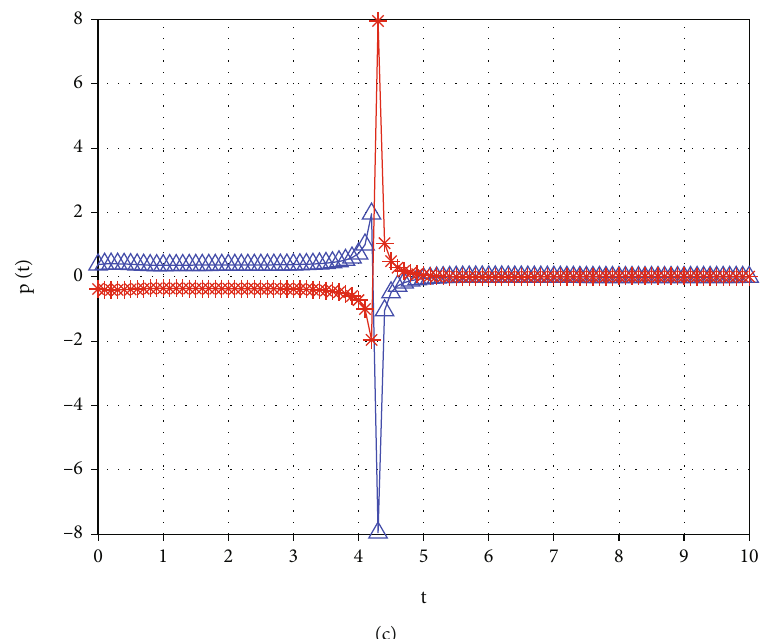
Figure 4: (a) The value of j p ð t Þj for t ∈ ½ 0, 1 (cid:2) . (b) The value p ð t Þ for t ∈ ½ 0, 1 (cid:2) . (c) The value of p ð t Þ for t ∈ ½ 0, 10 (cid:2)